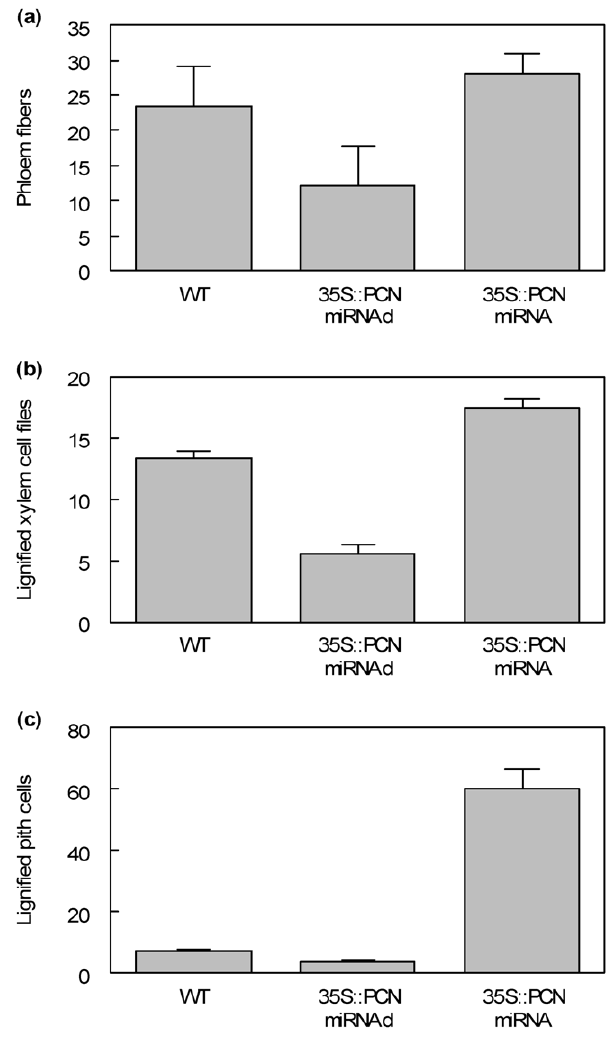
Figure 7. Quantification of phenotypes in bottom internode of 35S::PCN-miRNAd gain of function and 35S::miRNA-PCN knock- down transgenics. (a) Comparison of number of phloem fibers in the bottom internodes of wild-type, 35S::PCN-miRNAd gain of function and 35S::miRNA-PCN . (b) Comparison of number of lignified xylem cell layers in the bottom internodes of wild-type, 35S::PCN-miRNAd gain of function and 35S::miRNA-PCN . (c) Comparison of number of lignified pith cells in the bottom internodes of wild-type, 35S::PCN-miRNAd gain of function and 35S::miRNA-PCN . Relative expression levels (mean 6 SE) were calculated from three cross-sections of the bottom internodes of three independent wild type plants, three miRNAd gain of function transgenics, three 35S::PCN-miRNAd transgenics prepared from differ- ent batches of two month-old plants.